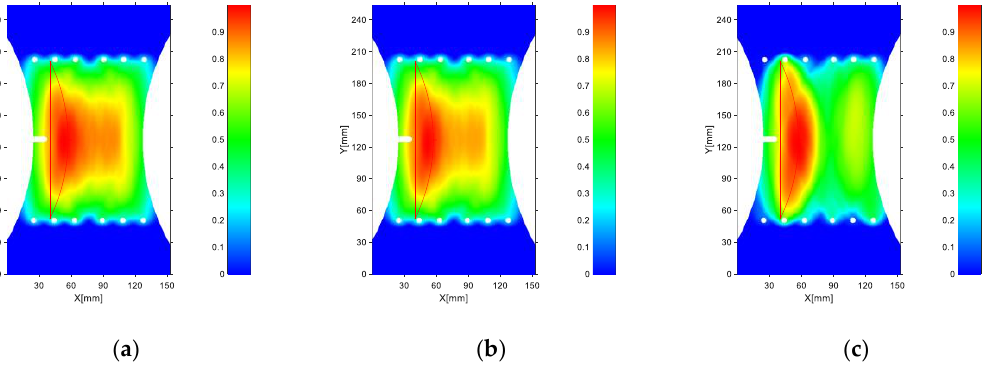
Figure 13. Images for different damage factors at 80,000 fatigue cycles: ( a ) energy damage factor; ( b ) cross-correlation damage factor; ( c ) sparse representation damage factor.